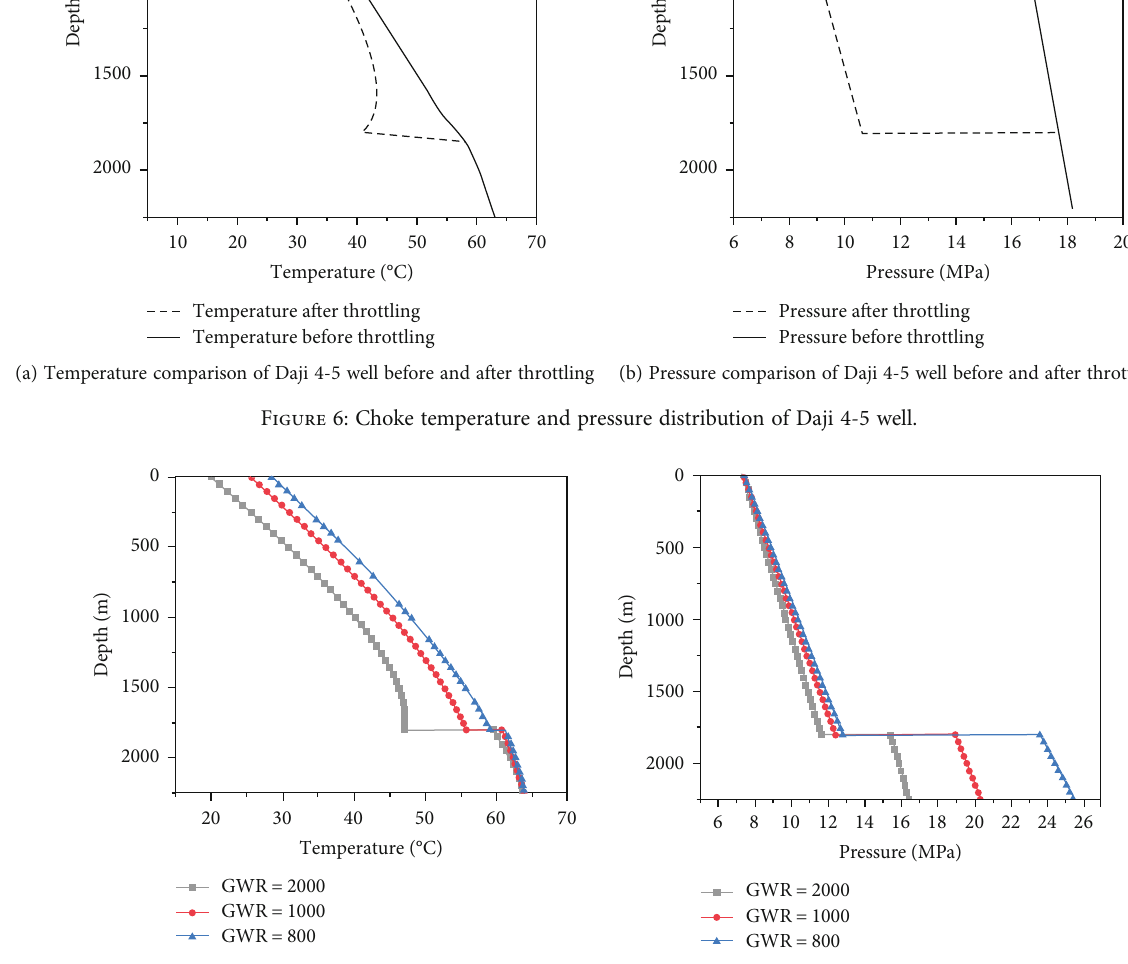
Figure 7: E ff ect of gas water ratio on throttle temperature and pressure